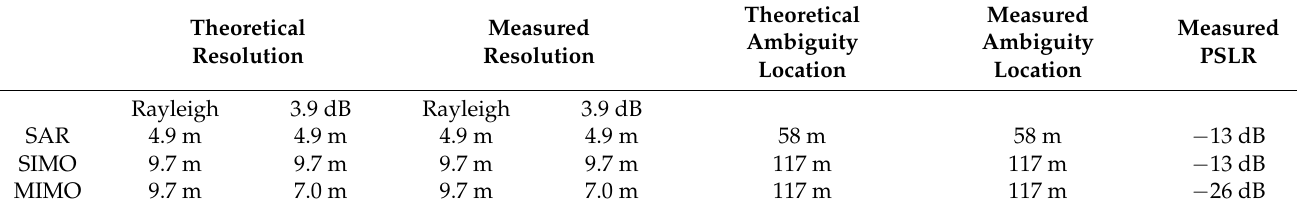
Table 2. Theoretical and measured tomographic resolutions and nearest ambiguity locations (along n ).